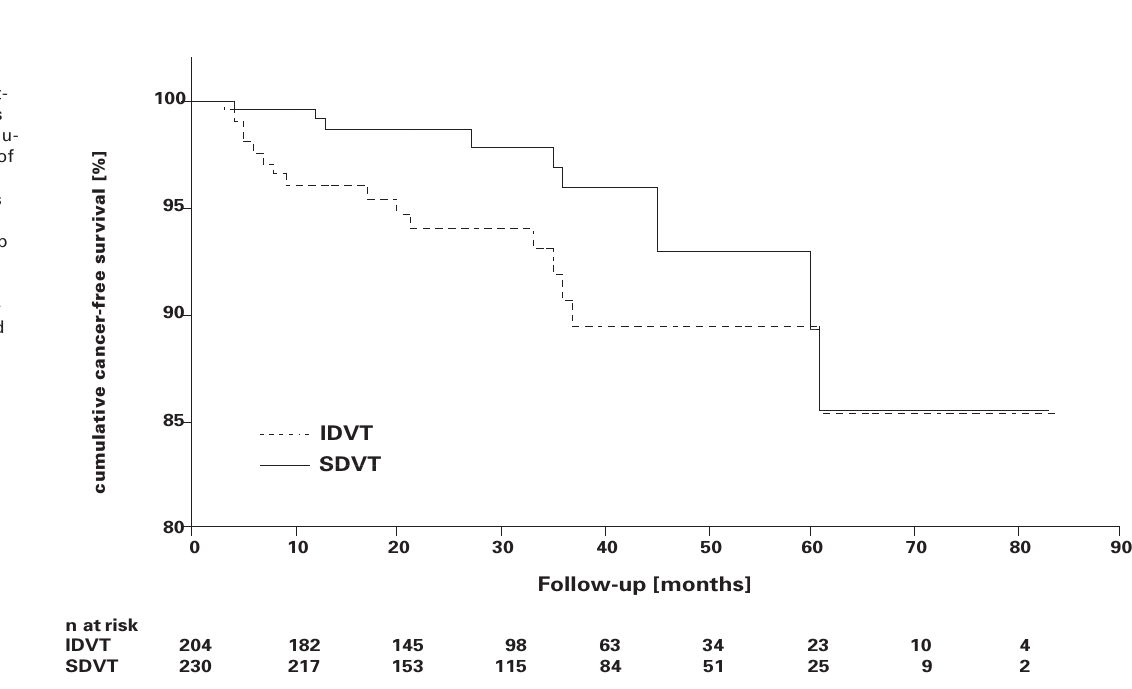
Kaplan-Meier event- free survival curves comparing the cumu- lative percentages of patients with idio- pathic deep venous thrombosis (IDVT) and secondary deep venous thrombosis (SDVT) who re- mained free of can- cer. There is a trend towards a higher incidence of cancer in patients with IDVT compared to those with SDVT (p =